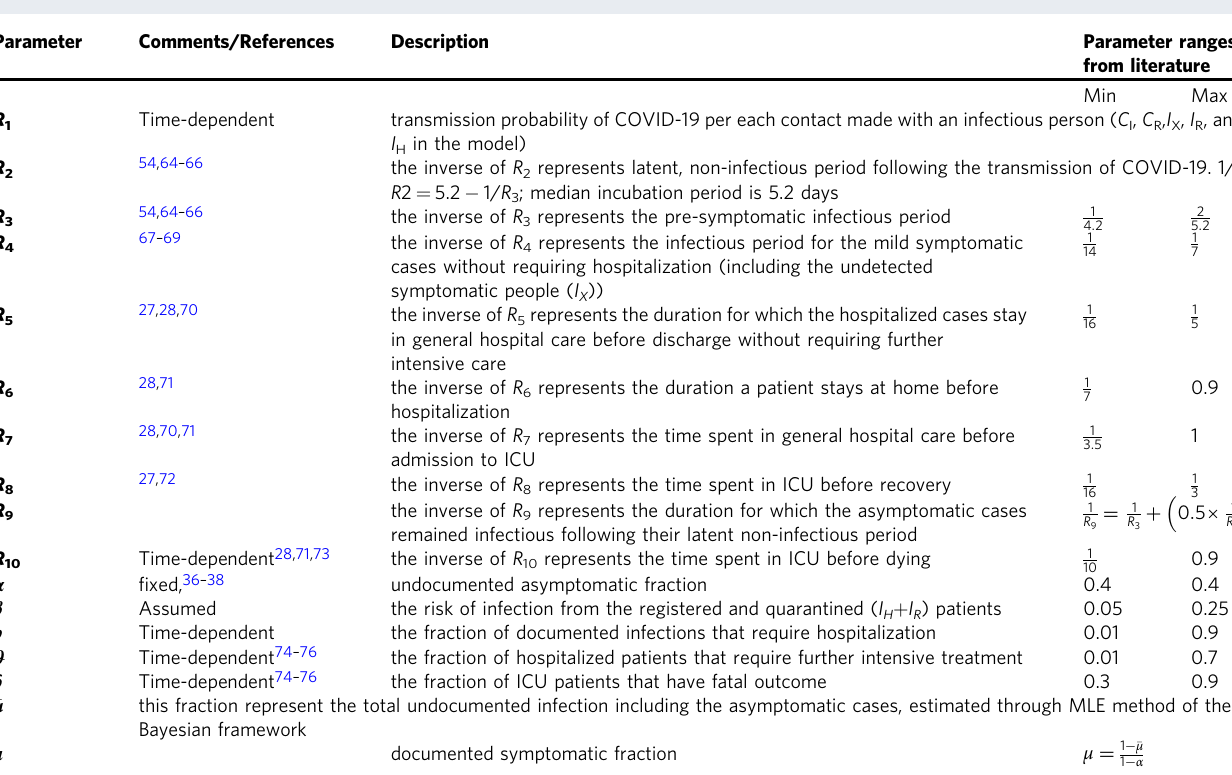
Table 1 Parameter ranges used in the Reference Model : determination of the boundaries for literature-based parameter set was based on the interpretation of the values given in the references 27,28,32